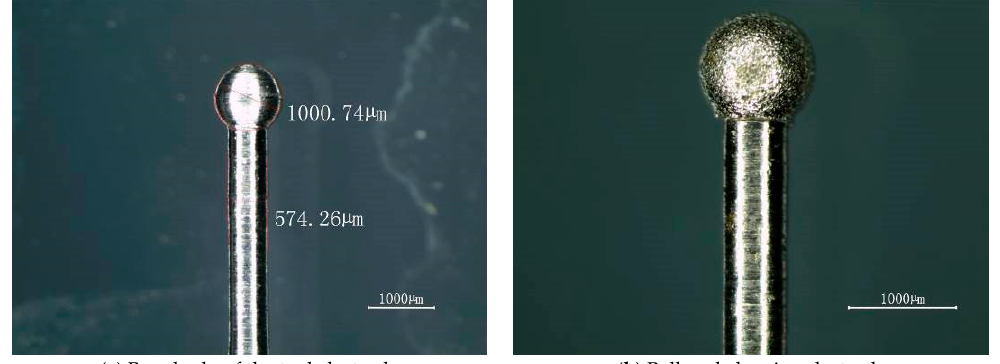
Figure 2. Tool electrode.